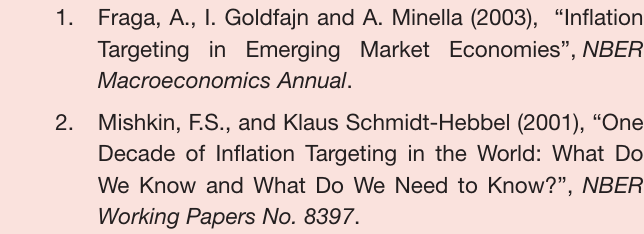
Chart II.2.3: Drivers of Food Inflation (Y-o-Y)